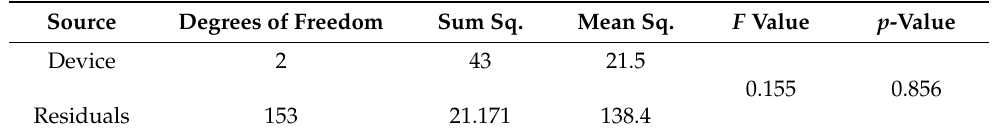
Table 5. One-way ANOVA table for comparison of mean indexes.